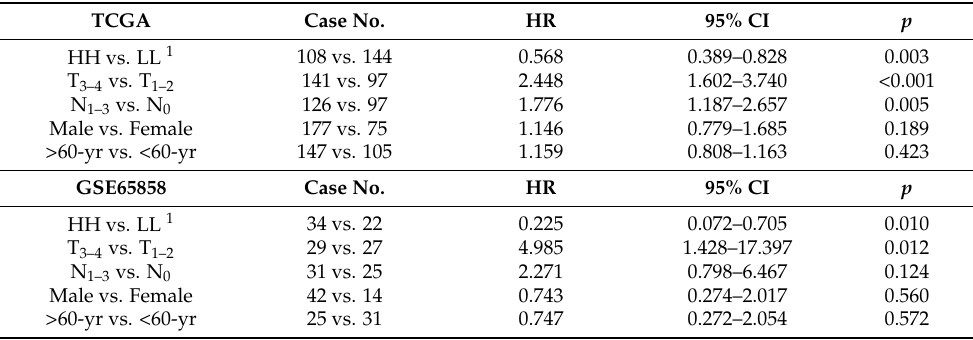
Figure 5. The connection between CXCL10 and STAT2 and the prognostic value based on their coordinated expression. ( A ) Ingenuity Pathway Analysis shows the connection between CXCL10 and STAT2. ( B ) The Spearman correlation between the expressions of CXCL10 and STAT2. ( C , D ) Kaplan-Meier plots of overall survival based on the coordinated expression of CXCL10 and STAT2 (HH vs. LL) in TCGA ( C ) and GSE65858 ( D ) oral cancer cohorts. The best cut-off values were computed using ROC curve analysis on the Kaplan-Meier plotter online tool. HH, both high. LL, both low. Table 3. Univariate Cox model analysis of overall survival.